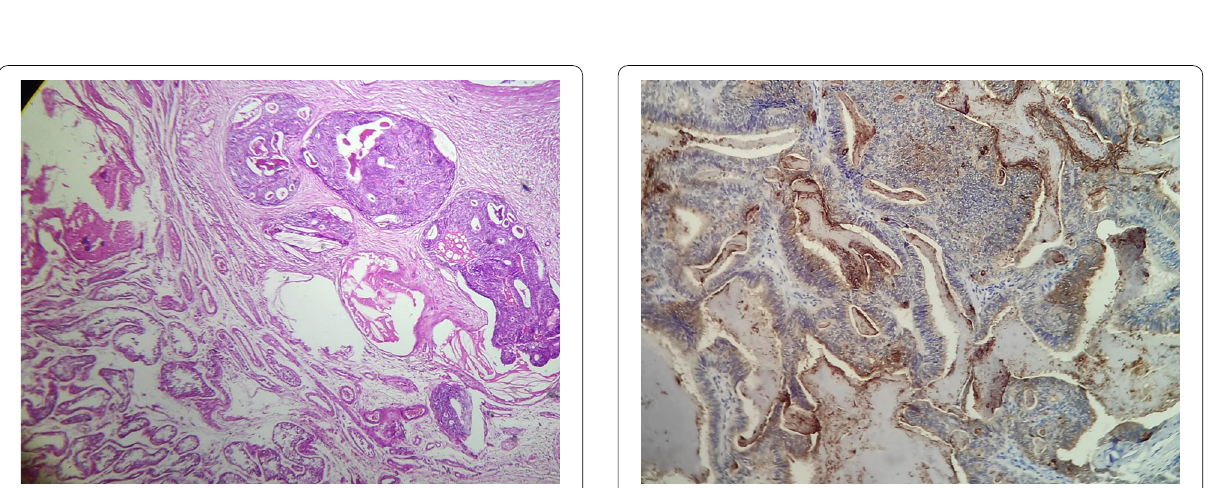
Fig. 4 Diffuse CK7 positive staining in tumor cells